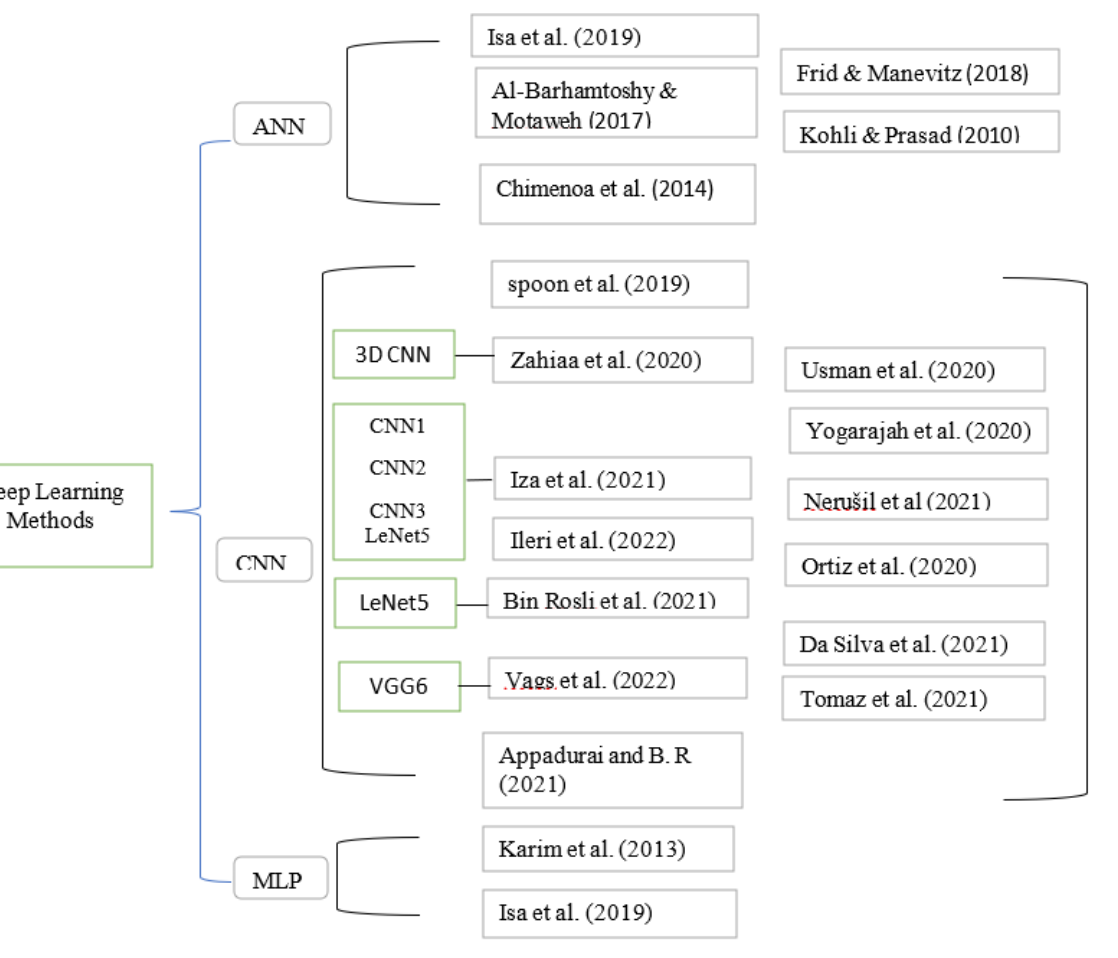
Figure 5. The reviewed studies organized according to the DL algorithms that each model adopted.